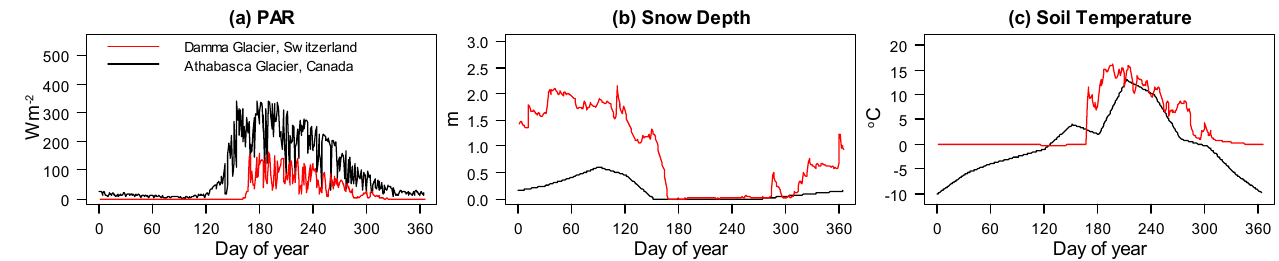
Figure 4. Annual meteorological forcings for SHIMMER for the Damma Glacier, Switzerland (red), and the Athabasca Glacier, Canada (black). Forcing data are provided by the WSL (Switzerland), Achuff and Coen (1980) and Staveley AAFC